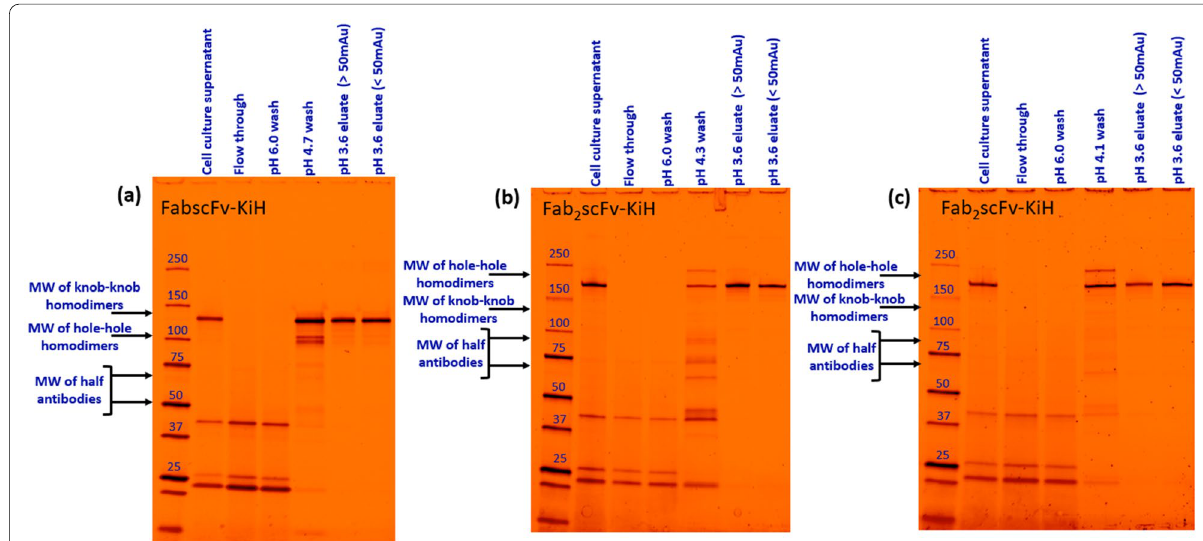
Fig. 8 SDS-PAGE gel illustrating the purity profile for different steps of the Protein A runs. FabscFv-KiH ( a ) and Fab 2 scFv-KiH with pH 4.3 wash step ( b ) and pH 4.1 wash step ( c )